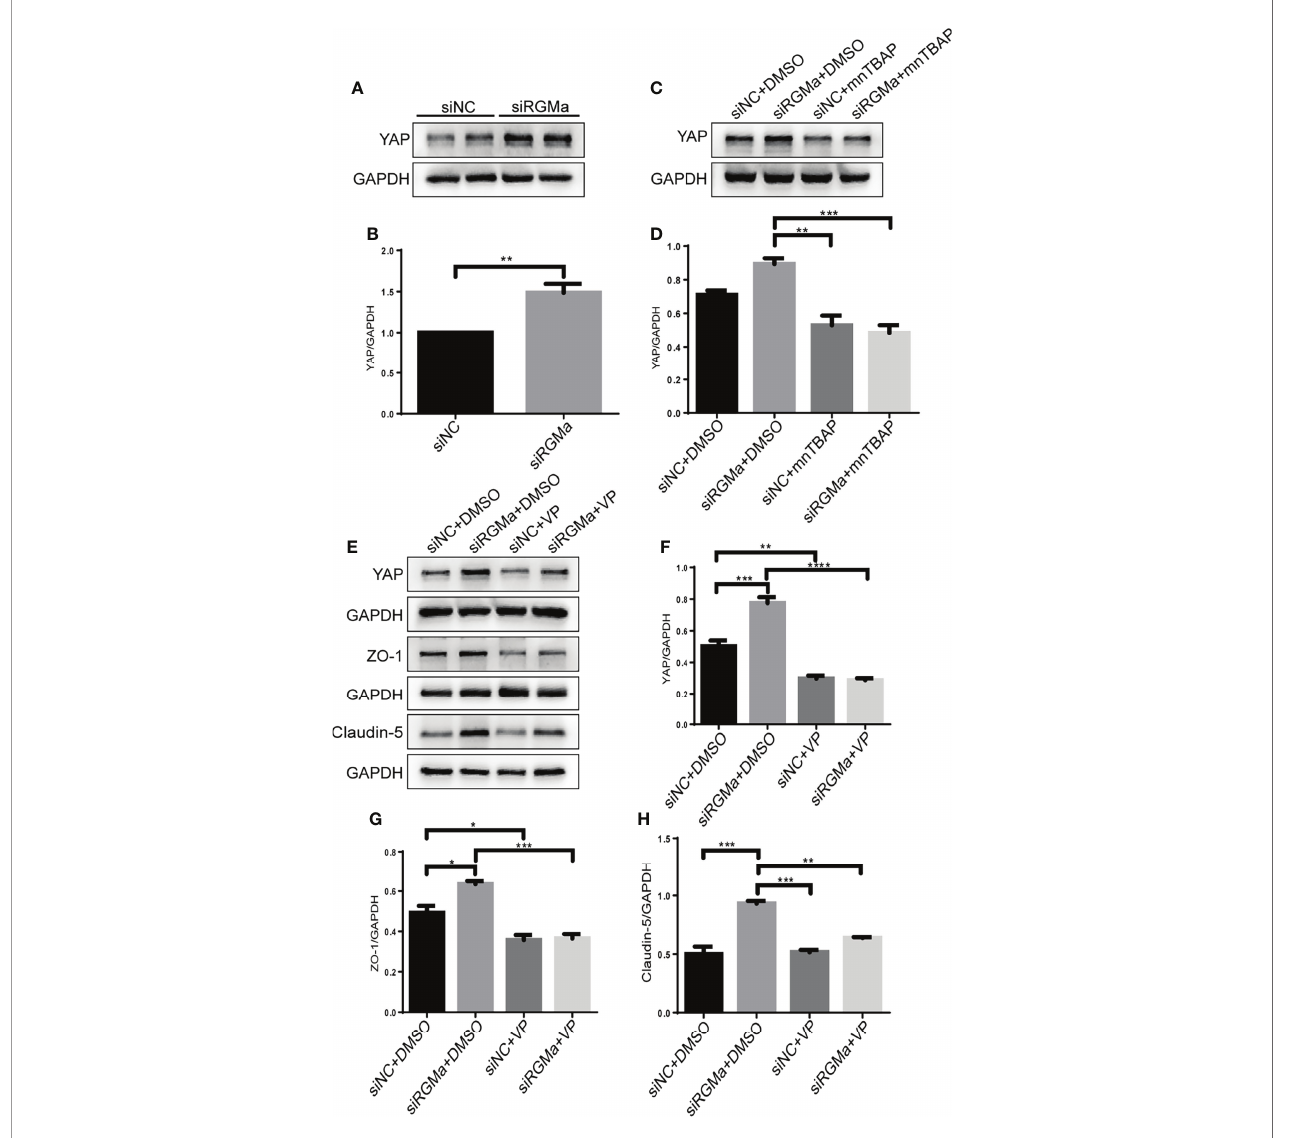
FIGURE 7 | Inhibiting YAP augments the permeability of the BBB and mediates via RGMa/BMP pathway. (A – D) Western blot analysis showed that YAP was signi fi cantly upregulated in the siRGMa group ( n = 3, ** p < 0.01, t -test) but signi fi cantly decreased when BMPR II was activated for 1 h with mnTBAP 100 µM ( n = 3, *** p < 0.001). (E – H) YAP, ZO-1, and claudin-5 levels were signi fi cantly reduced when YAP expression was speci fi cally inhibited by VP 2 µM for 24 h on the basis of RGMa knockdown ( n = 3, *p < 0.05, ** p < 0.01, *** p < 0.001, **** p < 0.0001, t